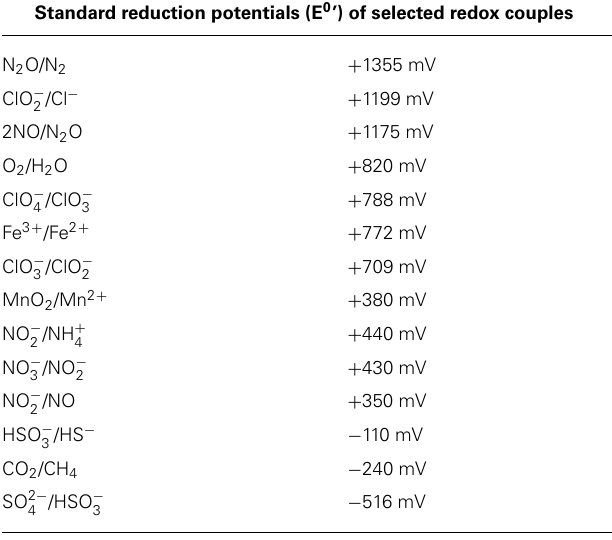
Table 1 | Standard reduction potentials of selected redox